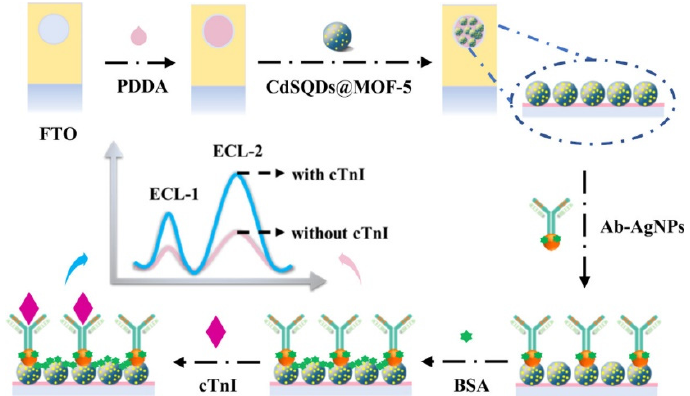
Figure 7. Examples of ECL immunosensors with physically adsorbed capture antibodies. Antibodies were immobilized on AgNPs to form an immunoaffinity layer. Reproduced with permission [100]. Copyright (2020) American Chemical Society.